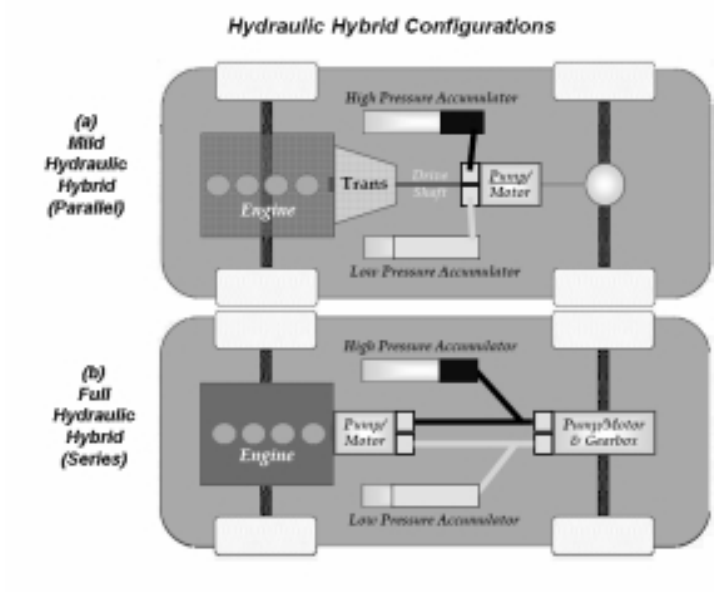
Fig. 1. Two main configurations of Hydraulic hybrid vehicles [27]: (a) parallel, (b)